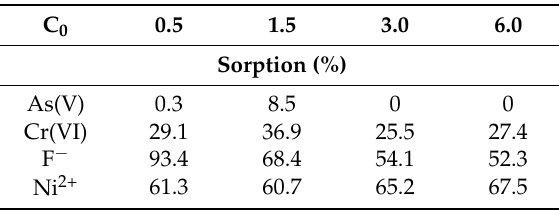
Table 1. As, Cr, F, and Ni percentage sorption on wheat straw for different concentrations added (C 0 )